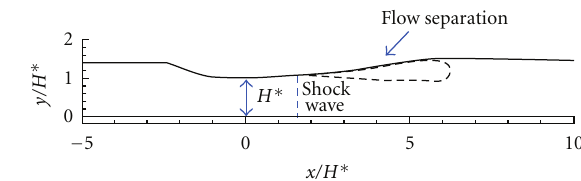
Figure 3: The transonic nozzle flow configuration which consists of vertical shock, shock-induced flow separation, and recirculation zone (Sajben Di ff user test case).